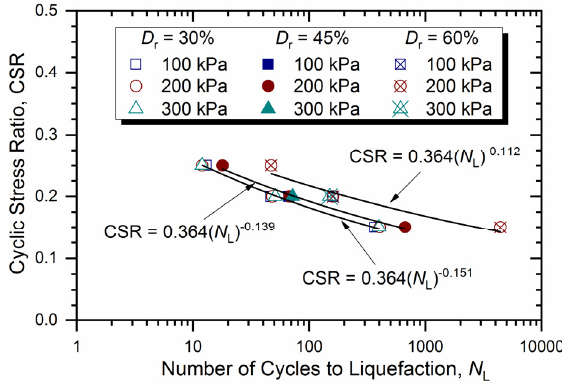
Figure 10. Cyclic strength curves for the calcareous sand.